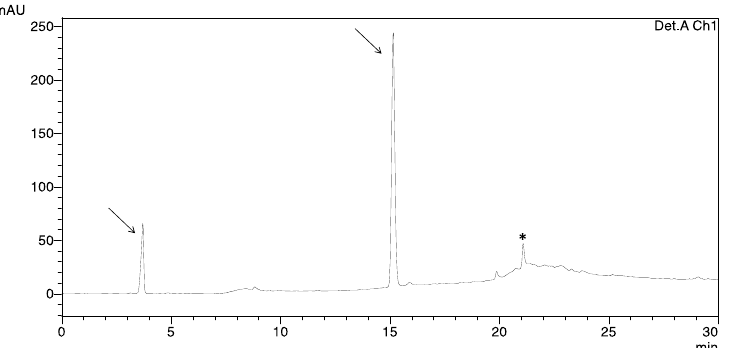
Figure 5. Chromatogram of on-resin NCS oxidation of HBD-3 (marked with asterisk); nonpeptide impurities are indicated by an arrow.